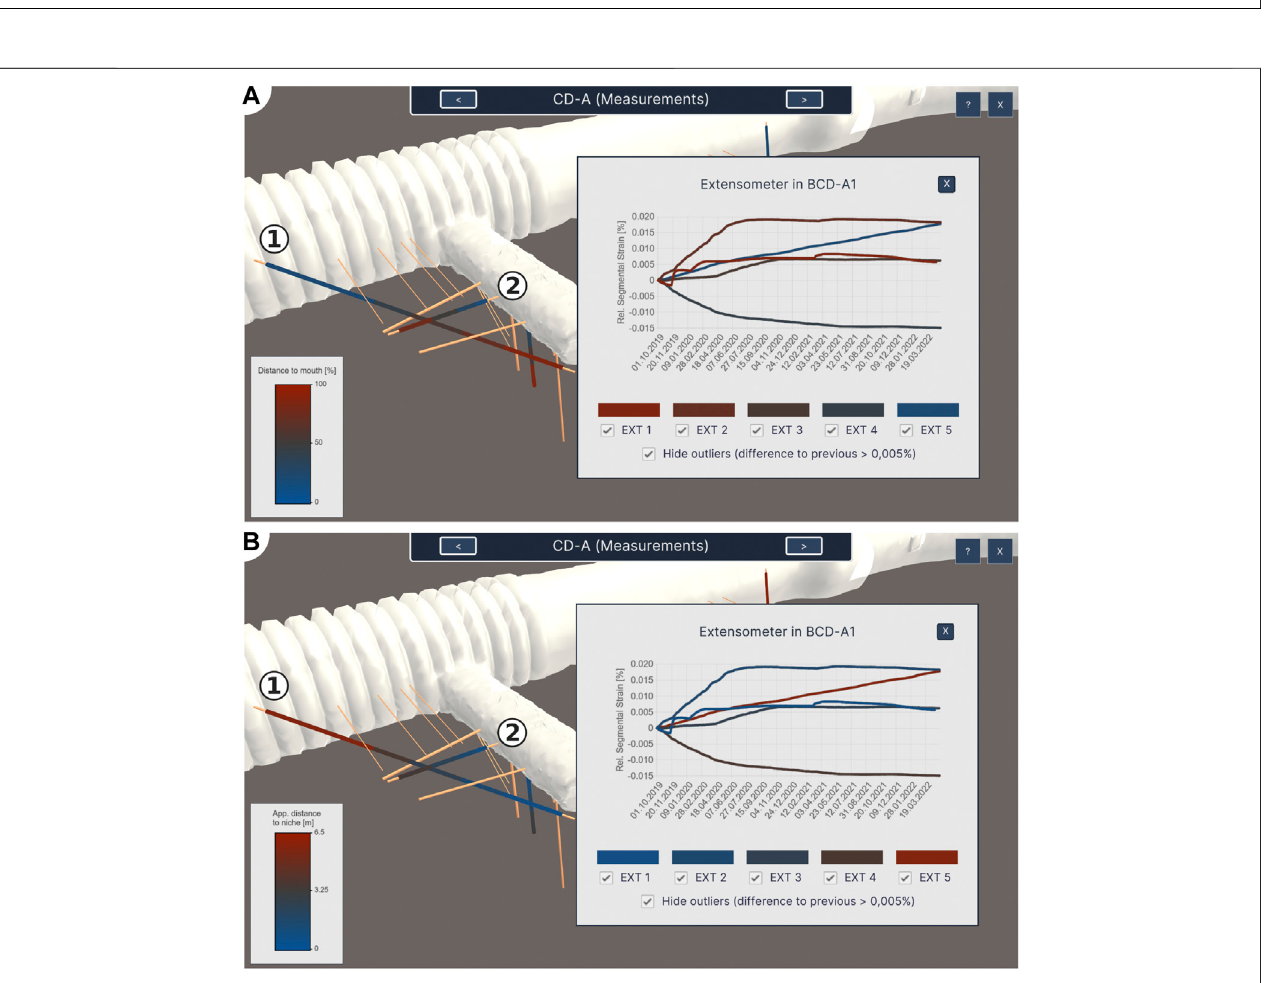
FIGURE6| The in-chart visualisation ofmeasurements exemplary forthe extensometer measurements inthescopeoftheCyclicDeformation Experiment (A) with sensorsegmentscolouredbydistance tothemouth oftheboreholeand (B) withsensorsegmentscolouredbydistance totheniche(usingacylinder thatapproximates the niche ’ s wall). Borehole CD-A1 that has been drilled from the Gallery is marked with (1) and Borehole CD-A9, as an example for a borehole drilled from the niche, is marked with (2).